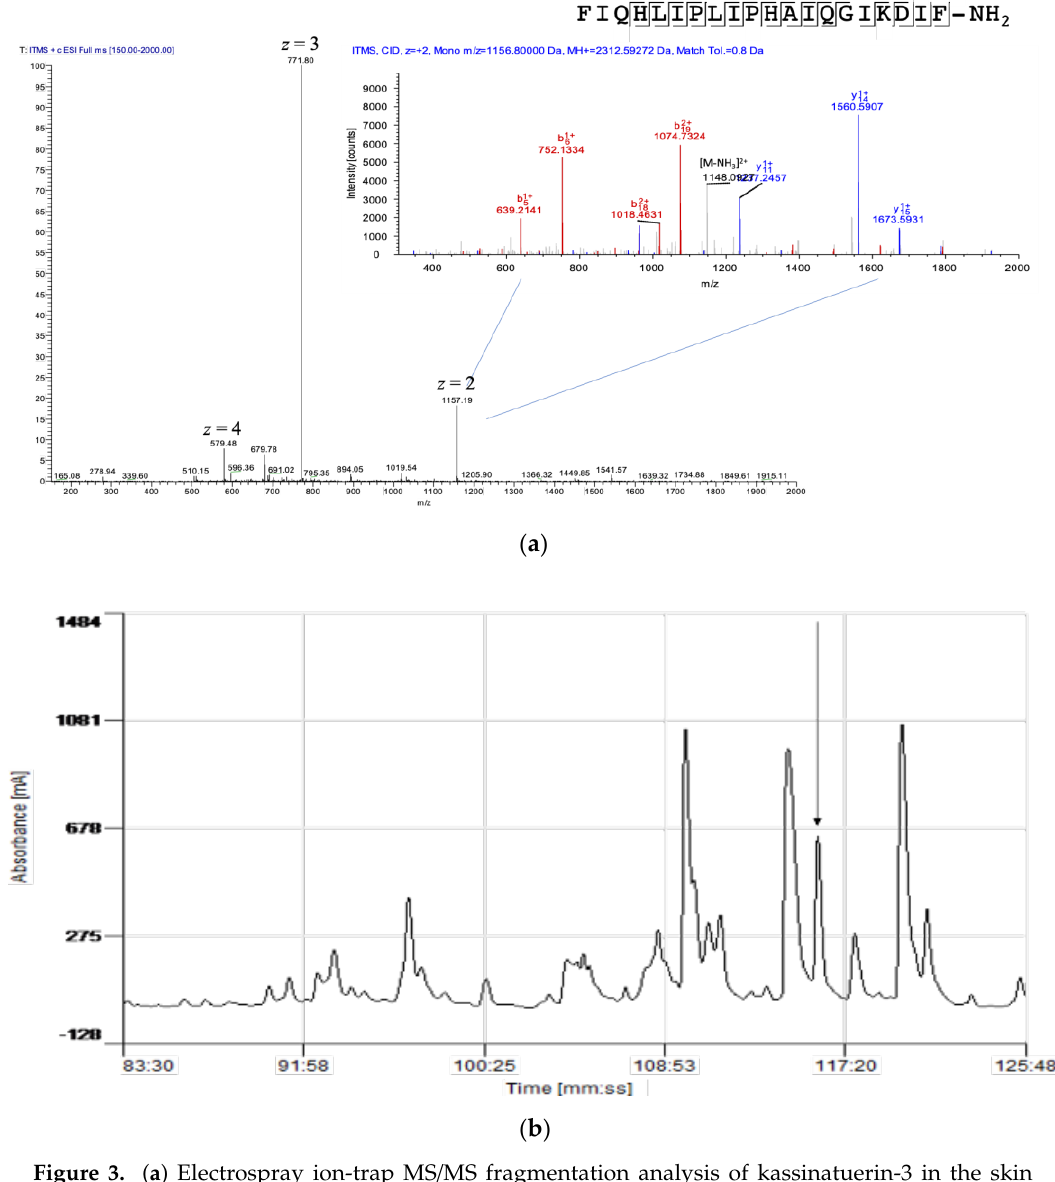
Figure 3. ( a ) Electrospray ion-trap MS/MS fragmentation analysis of kassinatuerin-3 in the skin secretion. The full mass scan exhibited multiple positively charged ions of kassinatuerin-3. The doubly charged precursor ion was subjected to MS/MS fragmentation (in the upper right-hand corner). The observed singly and doubly charged b-ion and y-ion fragments m/z ratios are colored as red and blue, respectively. (Note that, in the sequence call, I/L residues are isobaric and cannot be differentiated here. The assignation of I/L is done by reference to the cloned precursor template.) ( b ) Region of RP–HPLC chromatogram of the skin secretion of K. senegalensis , with an arrow indicating elution/retention time of the fraction (#116) containing the antimicrobial peptide, kassinatuerin-3. The Ɣ -axis indicates milli-absorbance units at λ = 214nm.